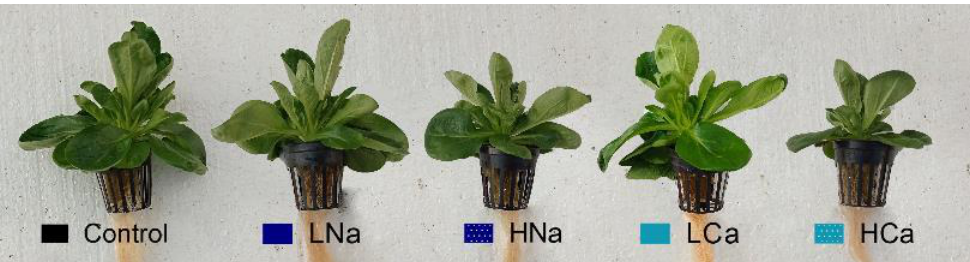
Figure 3. Valerianella locusta plants grown in a floating system at harvest stage, as influenced by four salinity treatments (referred to as low and high salinity level) and the salinity source. Control: standard nutrient solution (−0.08 MPa, 20 °C); LNa: low NaCl-salinity (−0.18 MPa, 20 °C); HNa: high NaCl-salinity (−0.28 MPa, 20 °C); LCa: low CaCl 2 -salinity (−0.018 MPa, 20 °C); HCa: high CaCl 2 -salinity (−0.28 MPa, 20 °C).